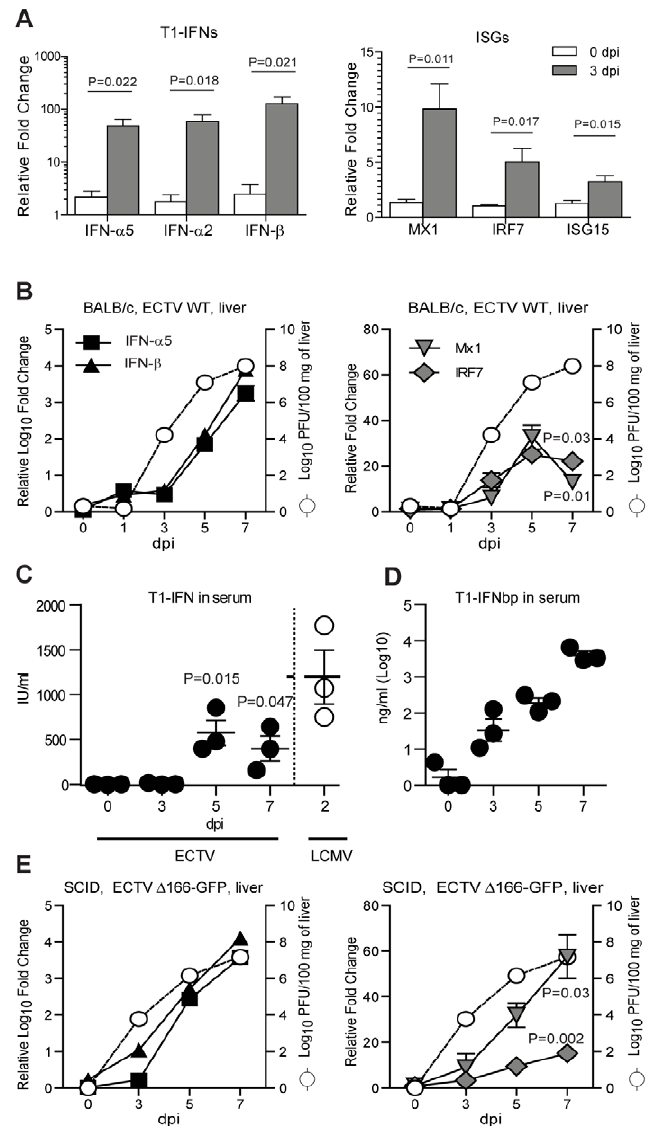
Figure 1. Type I IFN production and signaling depends on local virus replication and is blocked in situ by the T1-IFNbp. A ) BALB/c mice were infected with 100 PFU ECTV WT in the footpad. At the indicated dpi, IFNs and Mx1 transcripts were determined by RT-qPCR in the D-LN. B ) As in A, but the indicated transcripts were determined in the liver by RT-qPCR (left y axes) and virus titers were determined by plaque assay (open circles, right y axis, virus titers in upper and lower panels are identical data). C ) BALB/c mice were infected with 100 PFU ECTV and at the indicated dpi T1-IFN in serum was determined using ISRE-Luc reporter cells. Mice infected intraperitoneally with LCMV were used as a positive control (2 dpi). D ) BALB/c mice were infected with 100 PFU ECTV and at the indicated dpi T1-IFNbp in the sera was quantified using a sandwich ELISA and recombinant T1-IFNbp as standard. E ) As in B, but SCID mice were infected with ECTV D 166-GFP. All graphs show the mean 6 SEM and are representative of two or three similar experiments with 3–5 mice/group in each